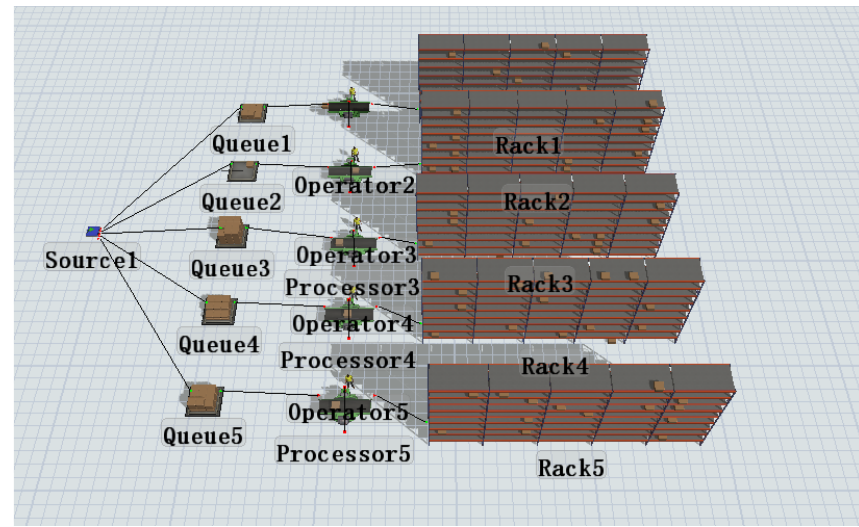
Figure 10. Simulation